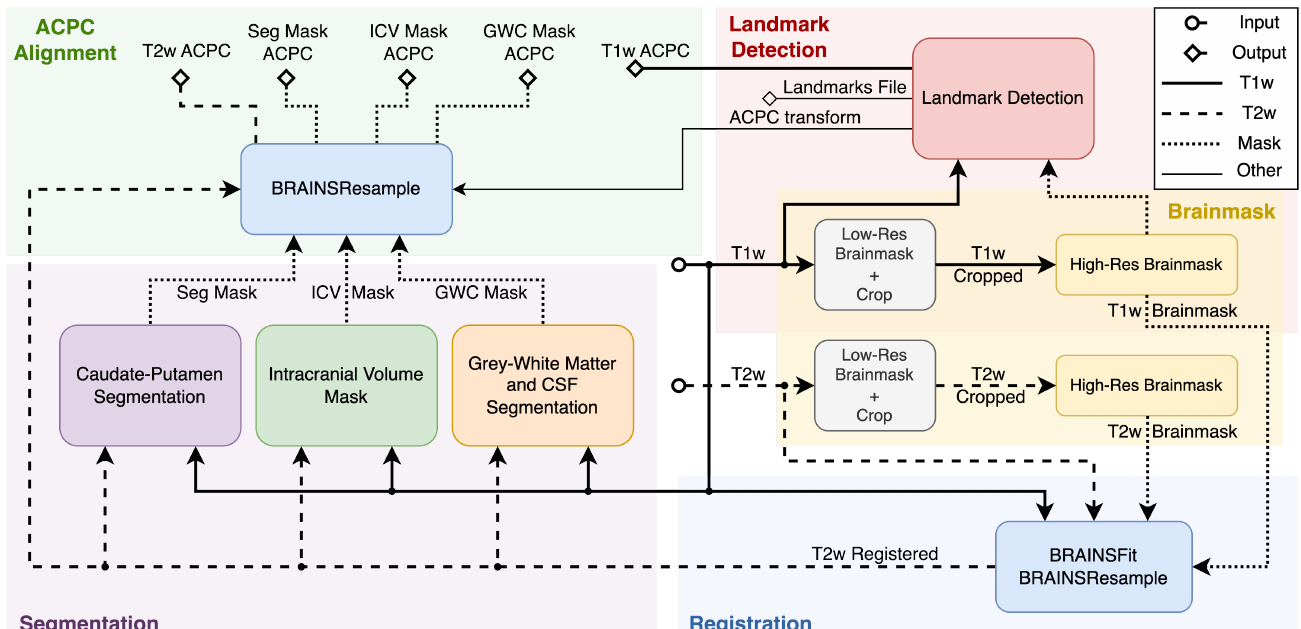
Figure 1. Simplified view of the pipeline’s dataflow. Input T1w and T2w images undergo brainmask generation in two steps to allow for robust image registration. Segmentation models use registered images to generate an intracranial volume mask, gray and white matter and cerebrospinal fluid tissue segmentation, and caudate and putamen masks. T1w image is also used to detect 19 anatomical landmarks and AC-PC transform, allowing for standardized alignment of all